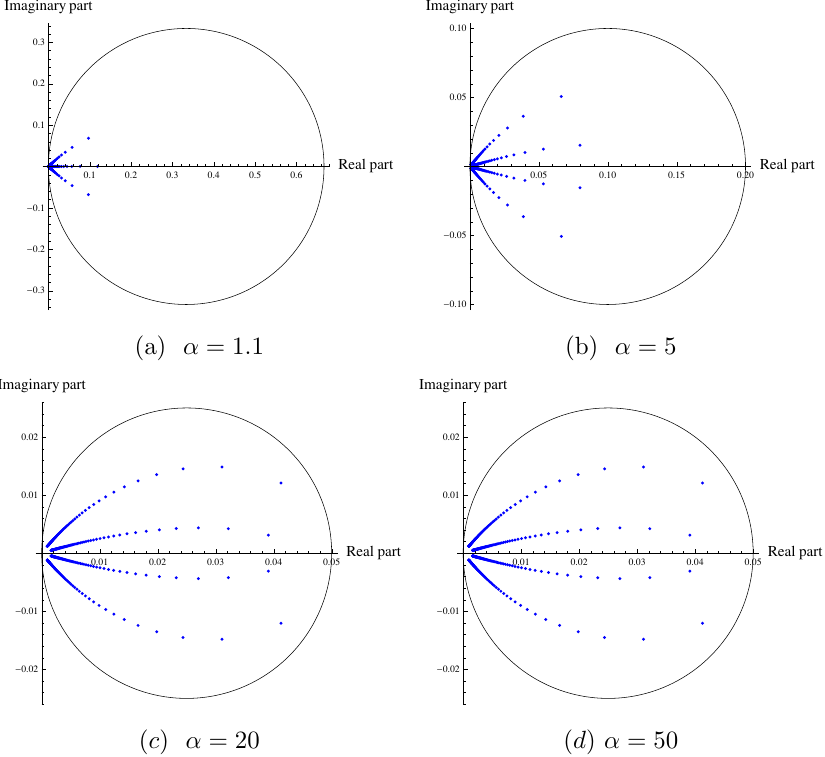
Figure 2. Eq. (4.4); eigenvalues of D i , i = 1 , 2 ,... ; cubic spline collocation with Gauss